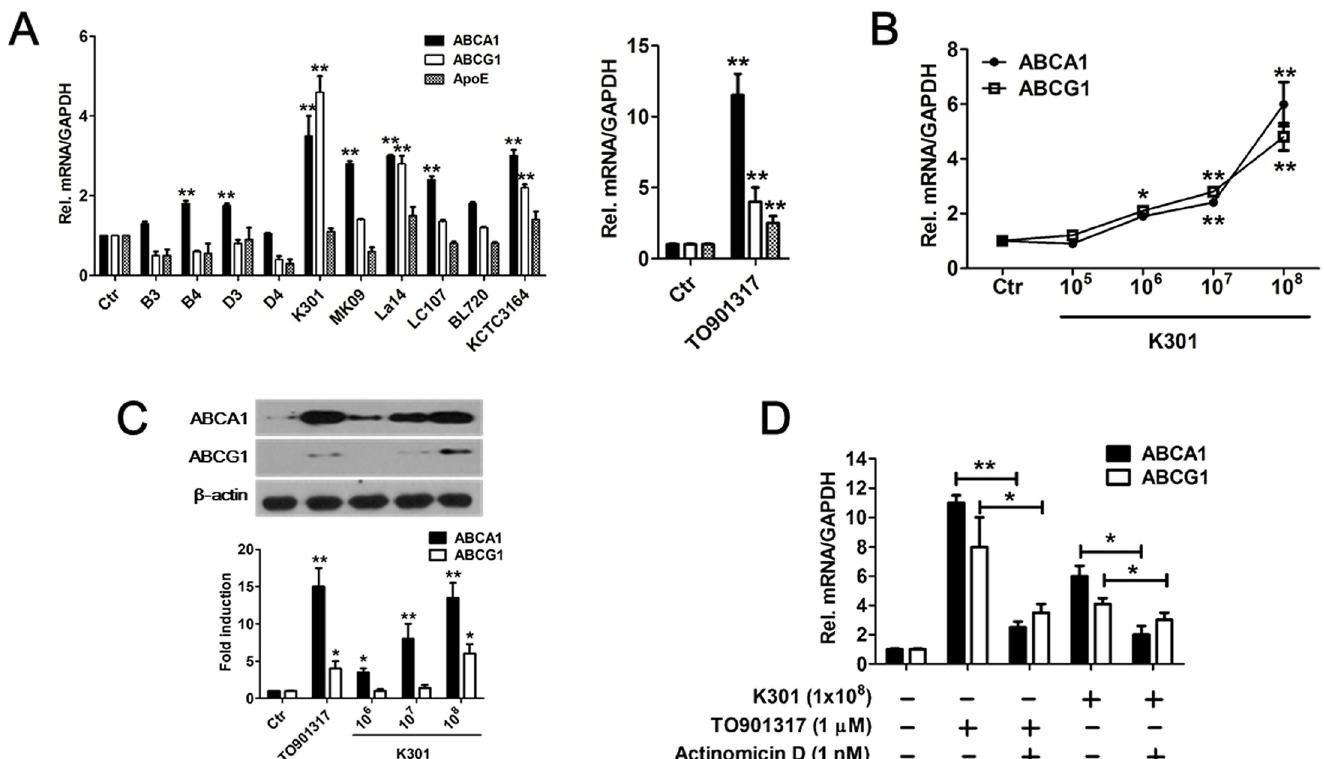
Fig 1. Effects of heat-killed lactic acid bacteria on LXR-related gene expression in macrophages. (A) THP-1 macrophages were incubated with 1×10 7 / ml heat-killed LAB or 1 μ M TO901317. Expression of ABCA1 , ABCG1 , and ApoE mRNA was examined by real-time PCR. (B) Cells were incubated with the indicated dose of heat-killed L . acidophilus K301 and the expression of ABCA1 and ABCG1 was examined by real-time PCR. (C) The protein expression of ABCA1 and ABCG1 was examined by western blotting using specific anti-ABCA1 and anti-ABCG1 antibodies. The amount of protein expression was normalized to beta-actin, and fold changes were presented by densitometry analysis (lower panel). (D) Cells were treated with heat-killed L . acidophilus K301 or TO901317 in the presence or absence of 1 nM Actinomycin D. The expression of ABCA1 and ABCG1 was examined by real-time PCR. mRNA expression was normalized to expression of GAPDH . Data are given as meanta a. * P < 0.05; ** P < 0.01 vs. control (Ctr). The error bars in individual samples are shown as variations from triplicate assays.